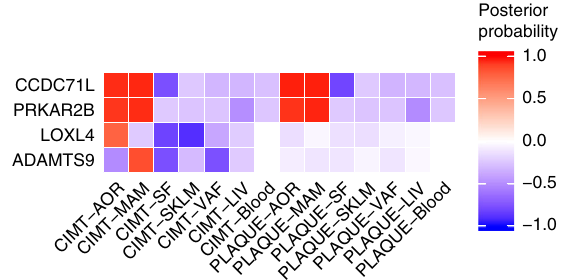
Fig. 2 Pairwise colocalization results for genes identi fi ed for cIMT and carotid plaque GWAS meta-analysis with STARNET expression datasets. Red indicates a high posterior probability of colocalization and blue a